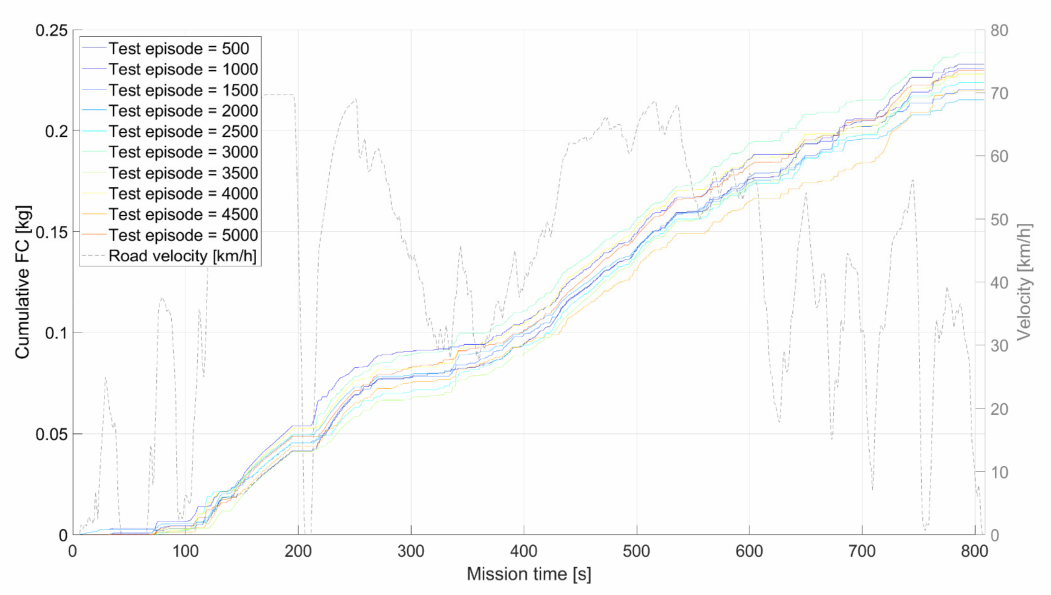
Figure 16. Cumulative FC over CLUST1 evaluated throughout several testing